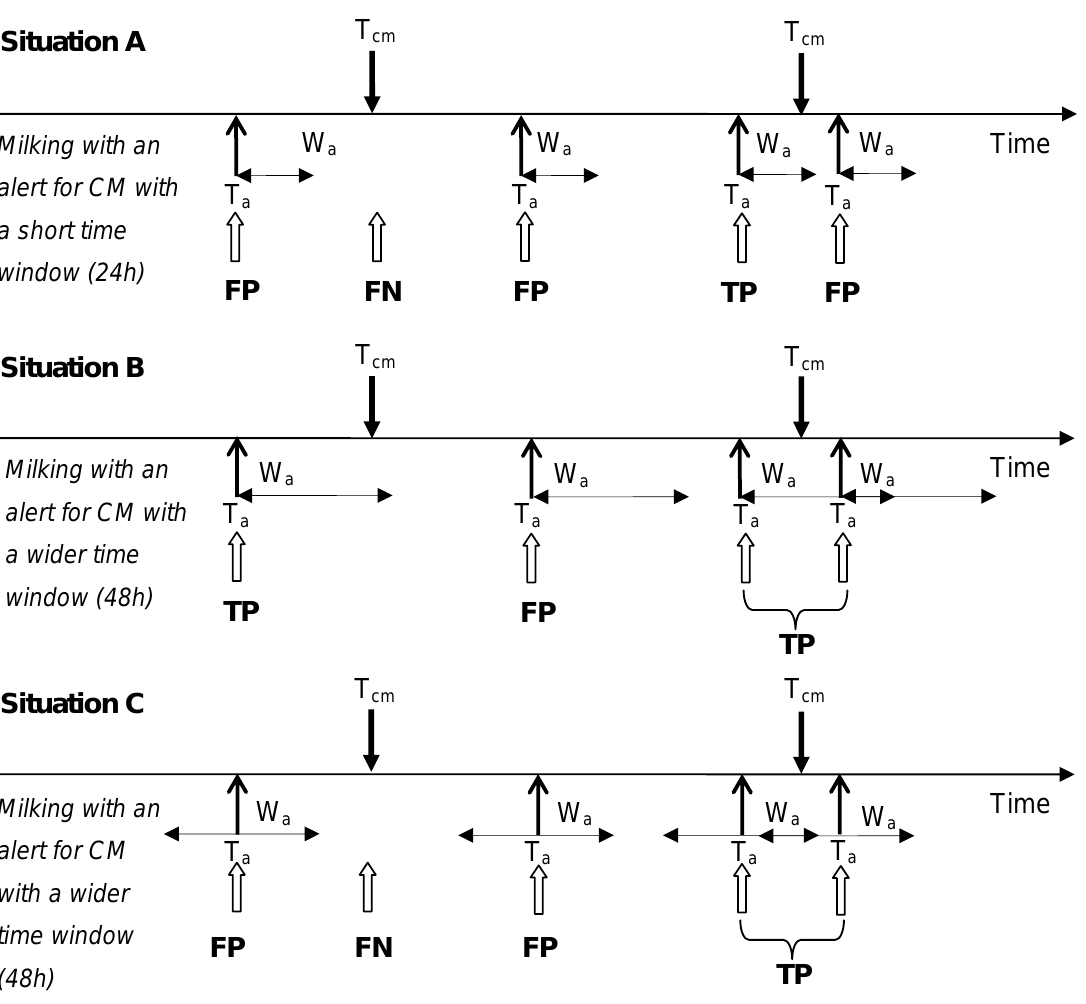
Figure 1. Applying different time windows (24 h, situation A; 48 h situation B; 24 h before and after an alert, situation C) to alerts (black arrows pointing up) for clinical mastitis (CM; black arrows pointing down) and its effect on the false positive (FP), false negative (FN), true positive (TP), and true negative (TN) alerts (white arrows pointing up). ) extended with a time window (W ) has no An FP alert occurs when an alert for CM (T a a observation of CM (T ) falling into that time window. An FN alert occurs when there is a cm T without any overlapping W . A TP alert occurs when there is a T with an extended cm a a time window W , in which a T falls. When two W overlap each other (see situation B a cm a and C) these alerts are labeled as one TP (in both situations B and C), FP, or